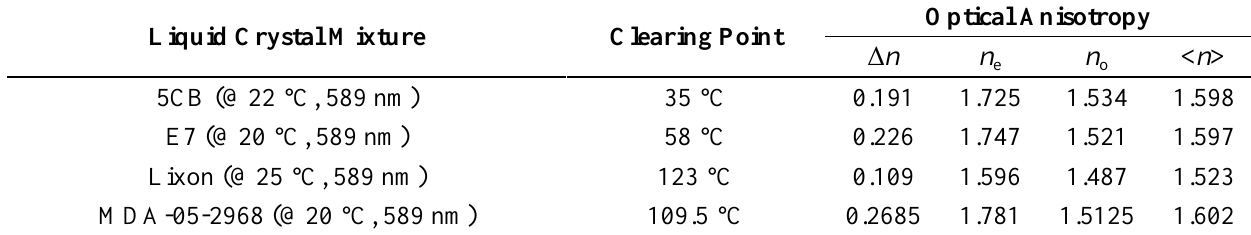
Table 1. Room temperature properties of liquid crystals used in the experiment. Liquid Crystal